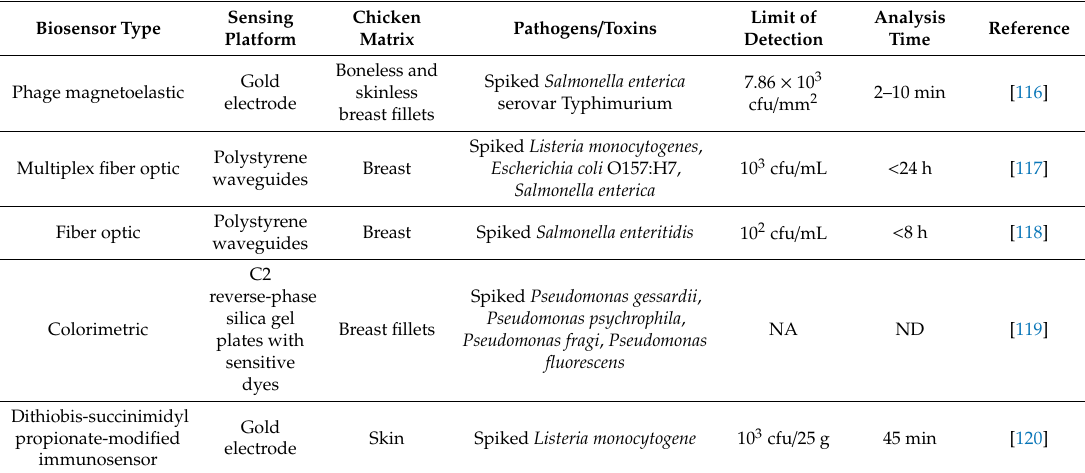
Table 8. Biosensor-based approaches used for the detection of chicken-borne